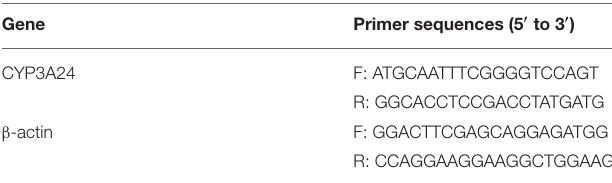
TABLE 3 | Primers sequences of goat CYP3A24 and β -actin for qPCR. Gene